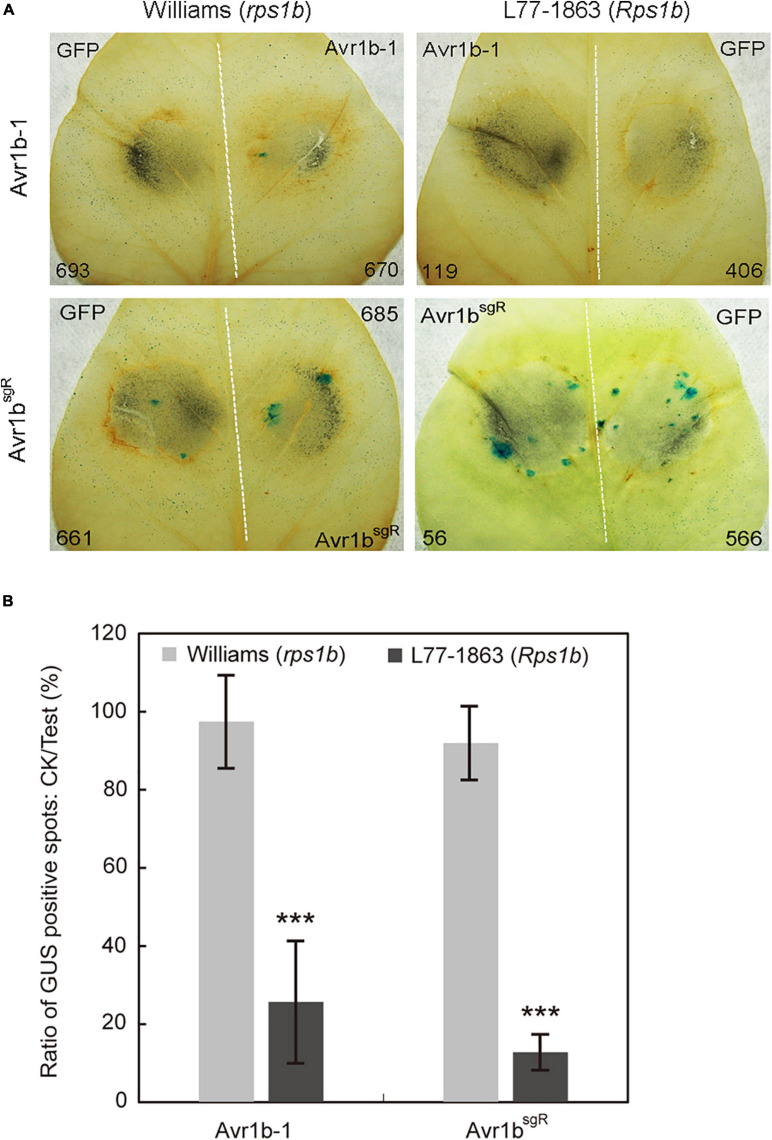
Transient expression of Avr1b-1sgR leads to cell death in Rps1b soybean leaves. (A) Soybean leaves from Williams (rps1b) and L77-1863 (Rps1b) were subjected to double-barreled particle bombardment with pairs of samples containing GUS reporter DNA plus either Avr1bsgR DNA or GFP control DNA. After staining, the numbers of blue spots on Williams (rps1b) and L77-1863 (Rps1b) leaves were counted. A functional Avr1b-1 gene is expected to significantly reduce the number of blue spots on L77-1863 (Rps1b) leaves, but not Williams (rps1b) leaves, due to triggering Rps1b-mediated cell death. The white dotted line separates the two bombardment sites. Numbers of GUS spots counted are indicated. (B) Ratios between the numbers of GUS spots produced in the presence of Avr1b-1 vs. control GFP DNA on each leaf, averaged from 10 soybean leaves, in a single experiment. Error bar represents the mean ± standard deviation. The significance of the difference between Williams and L77-1863 leaves was determined by the Wilcoxon rank sum test (Gu et al., 2011), ***P < 0.001.